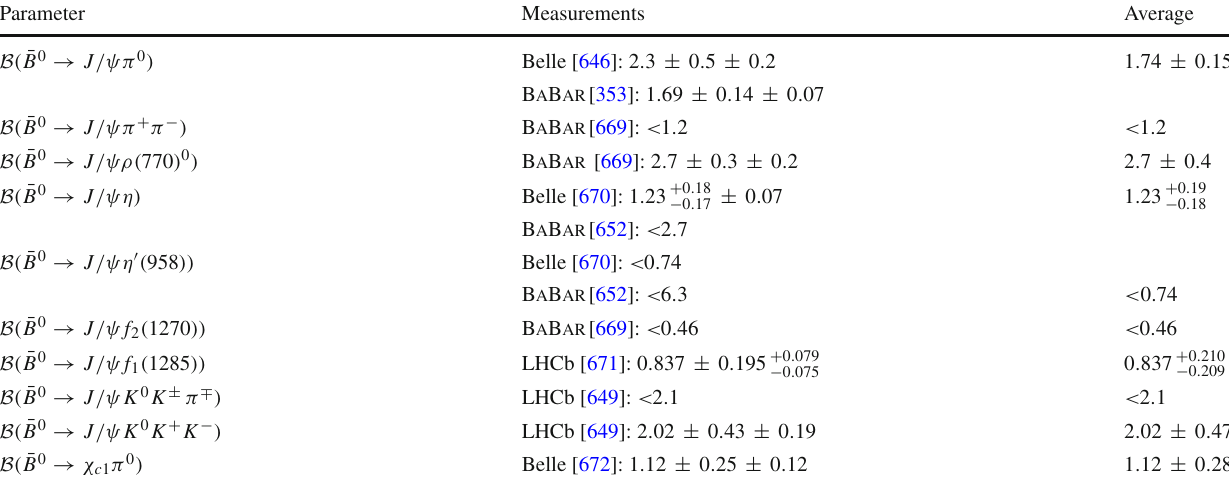
Table 119 Decays to charmonium and light mesons I [ 10 − 5 ] Parameter